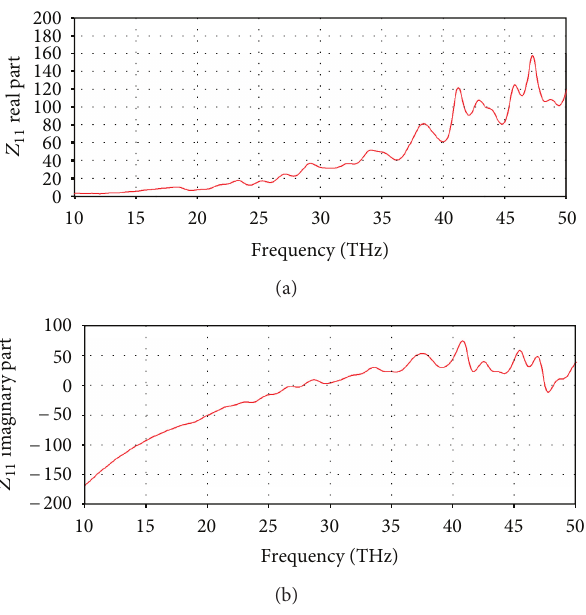
Figure 7: Input impedance of optimized bowtie antenna: (a) resistance and (b) reactance.